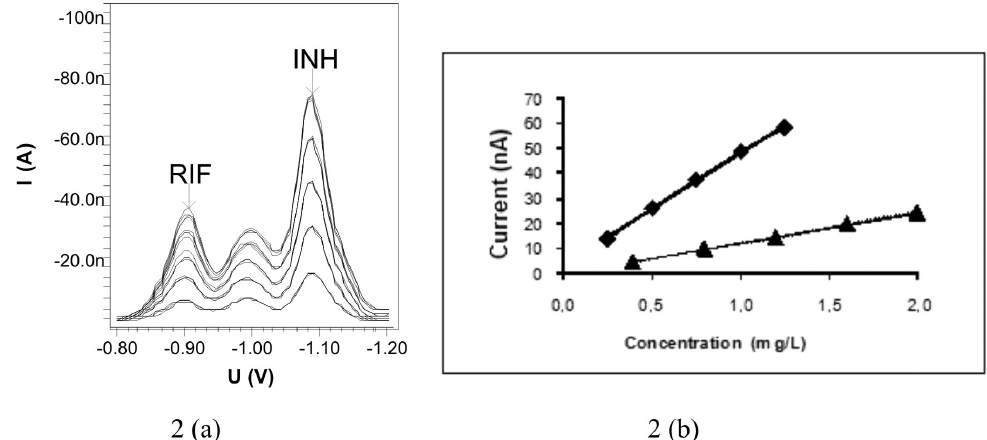
FIGURE 2 – Voltammograms (a) and analytical curves (b) of INH ( ¿ ) 0.25; 0.50; 0.75; 1.00 and 1.25 mg/L and of RIF ( p ) 0.40; 0.80; 1.20; 1.60 and 2.00 mg/L with buffer McIlvaine pH 7.0 as support electrolyte, in the conditions described at Table